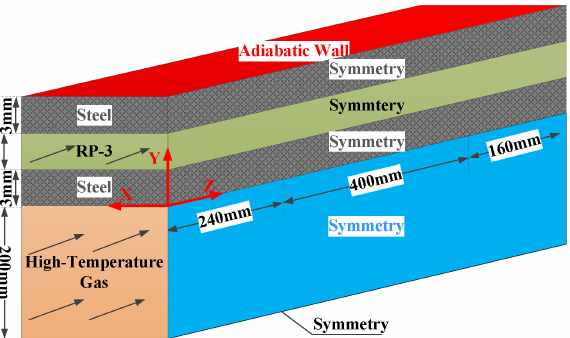
Figure 6. Physical model of the three-dimensional coupled heated transfer used for numerical valida- tion.